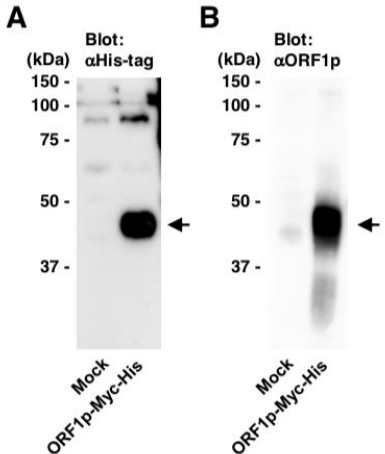
Figure 3. Generation of an antibody against L1 ORF1p. A rabbit antibody against L1 ORF1p (#18469) was generated using a synthetic ORF1p peptide [27–45 aa]. The homogenate of the cells transfected with pEF-Myc-His (Invitrogen) or pEF-ORF1p-Myc-His was subjected to western blotting using anti-His-tag ( A ) and anti-ORF1p (#18469) antibodies ( B ). Arrows, bands of ORF1p.